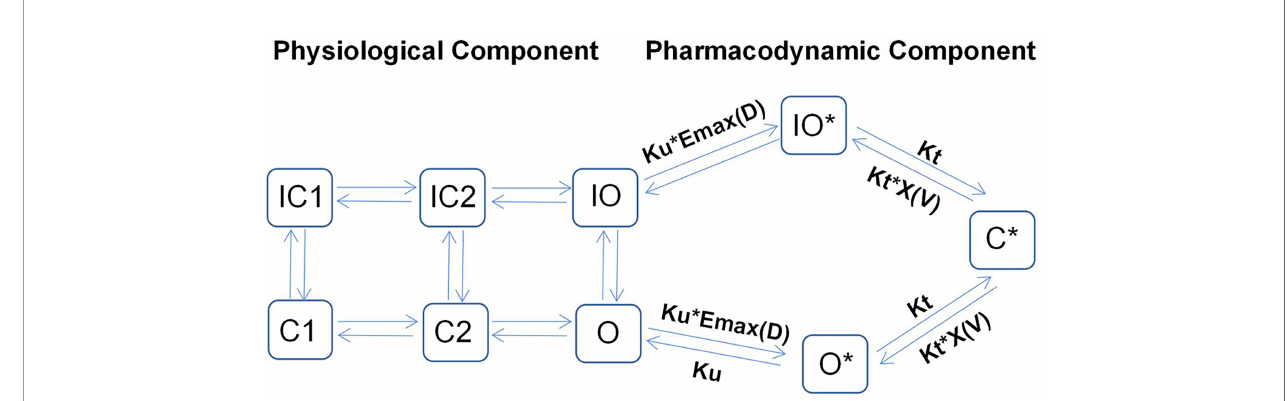
FIGURE 1 | Illustrative structure of a dynamic hERG-binding model. The left part corresponds to the physiological component of the model, where C1 and C2 represent the closed states of the channel and O represents the open state, with the corresponding inactivated states indicated as IC1, IC2, and IO, respectively. The right part represents the pharmacodynamic component, which assumes three drug-bound states: open bound (O*), inactivated open bound (IO*), and closed bound (C*). The drug can be trapped in the C*